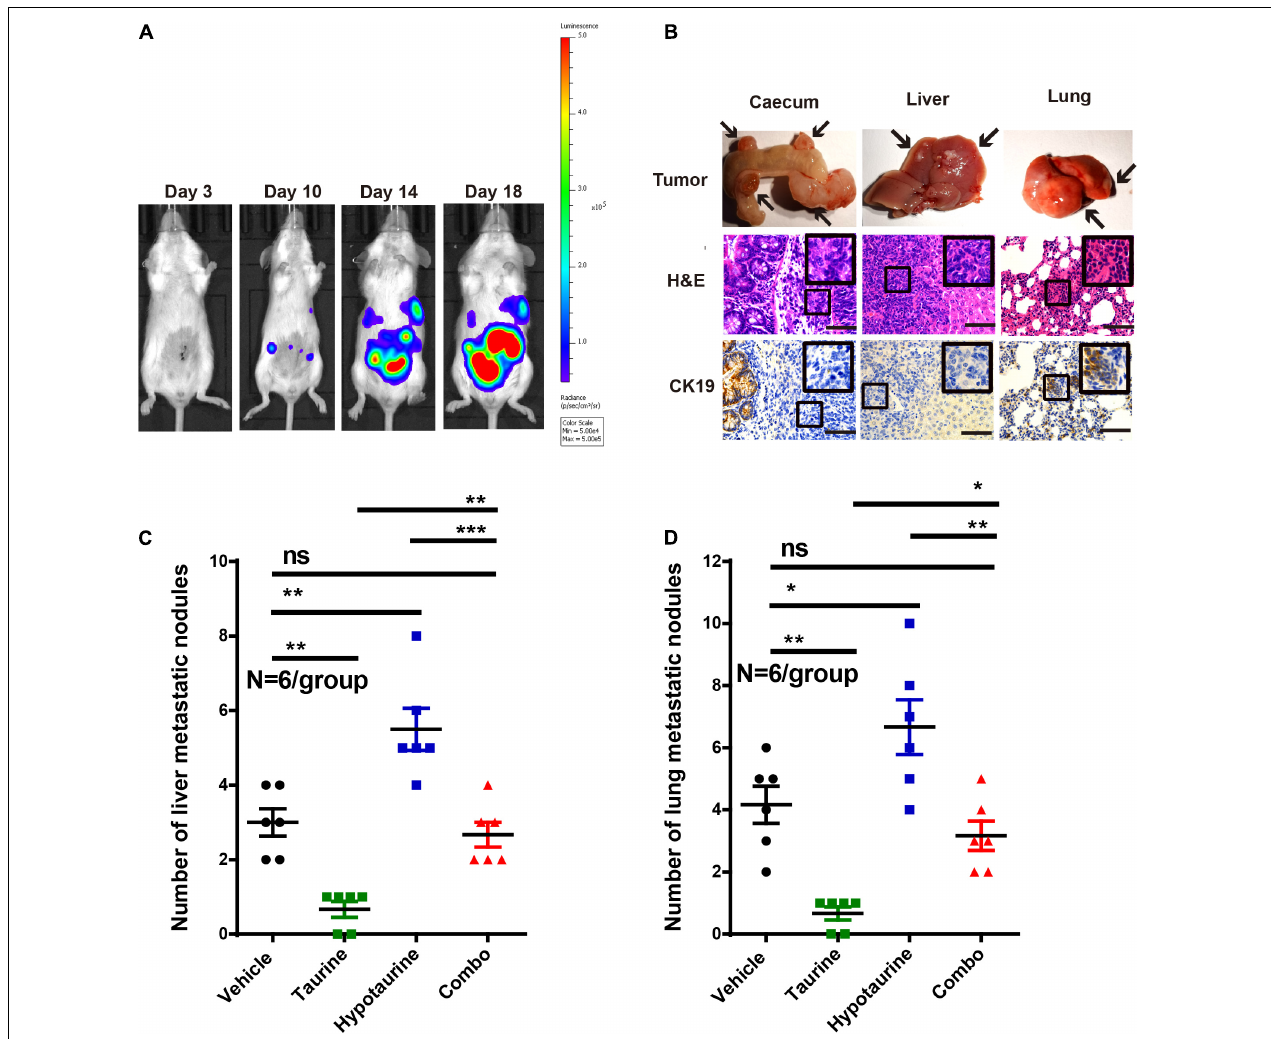
FIGURE 8 | Taurine reverses the promoting effects of hypotaurine on tumor metastasis in vivo . (A) Representative images of total mouse luciferase signal were shown, manifesting the presence of tumor formation, liver, and lung metastases. (B) The cecum, liver, and lung of mice were stained with H&E and cytokeratin 19. The arrows represented macroscopic cecal tumor and metastatic spots (magnification 200 × ; scale bars, 50 µ m). (C,D) Quantitative results of metastatic area as liver/lung (mean ± SEM) ( N = 6/group; one-way ANOVA followed by Tukey’s post hoc test, * P < 0.05, ** P < 0.01, *** P <